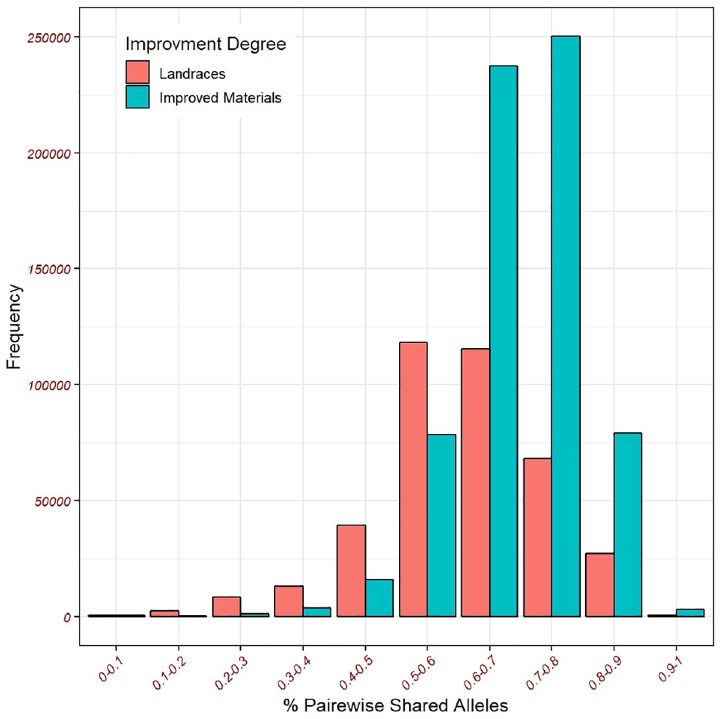
Fig 3. The distribution of the pair-wise shared alleles for the improved accessions and the landraces.